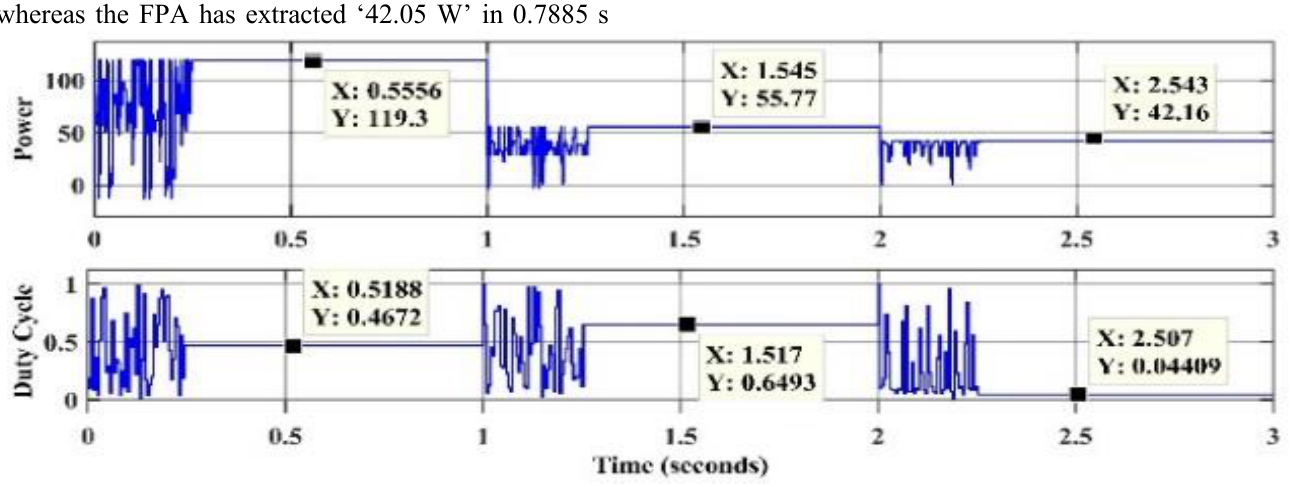
Fig. 12. Performance of AFPA under continuous changing weather